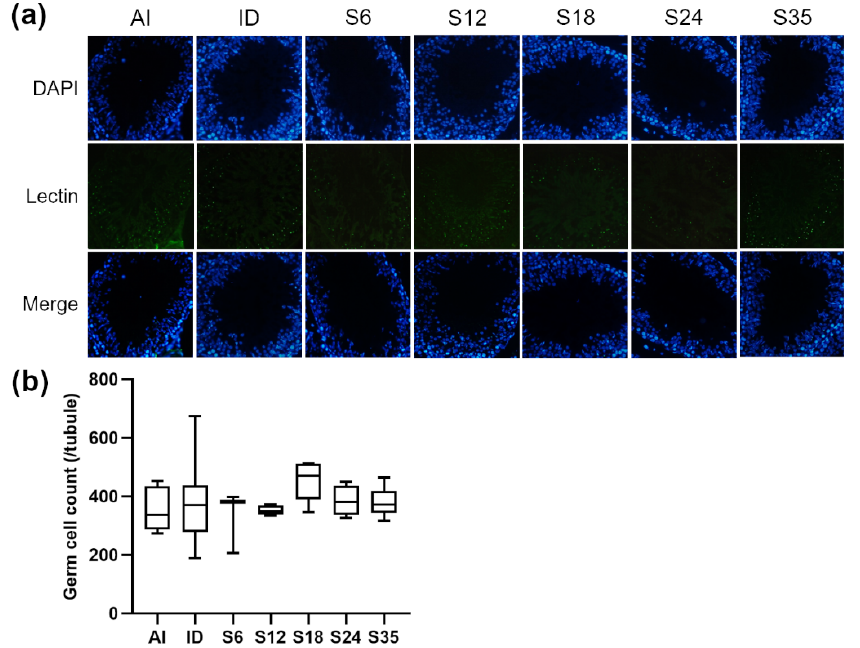
Figure 5. Effects of different doses of iron supplementation on ( a ) testicular seminiferous tubules by DAPI (nucleus) and Lectin (acrosome) staining, and ( b ) germ cell numbers in stages II-III of spermatogenesis in iron-deficient rats. Values are presented as median (interquartile range, IQR). n = 4 per group.